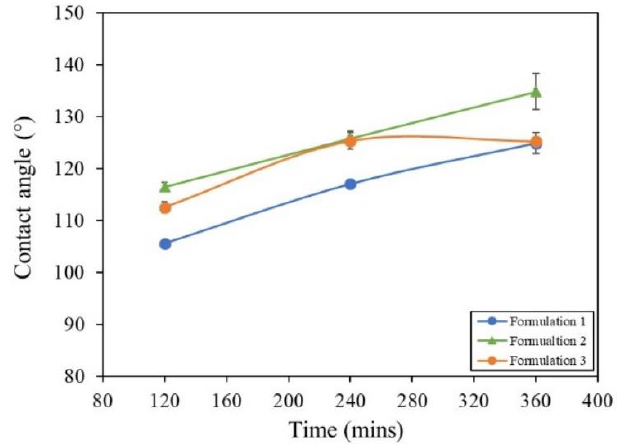
Figure 3. Relationship between CA against immersion time for formulations 1–3 from Table 1.